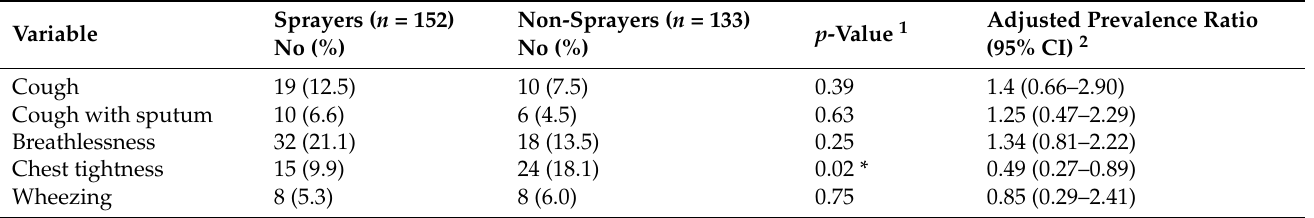
Table 3. Respiratory symptoms among spraying and non-spraying flower farm workers in Ethiopia ( n =